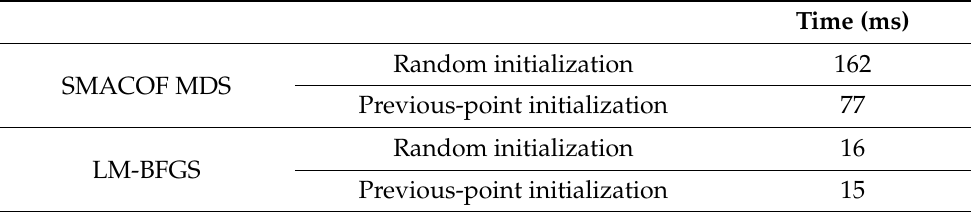
Table 7. Average computation time of individual positions after 1000 executions of the gesture of Figure 7a using SMACOF MDS and LM-BFGS optimization